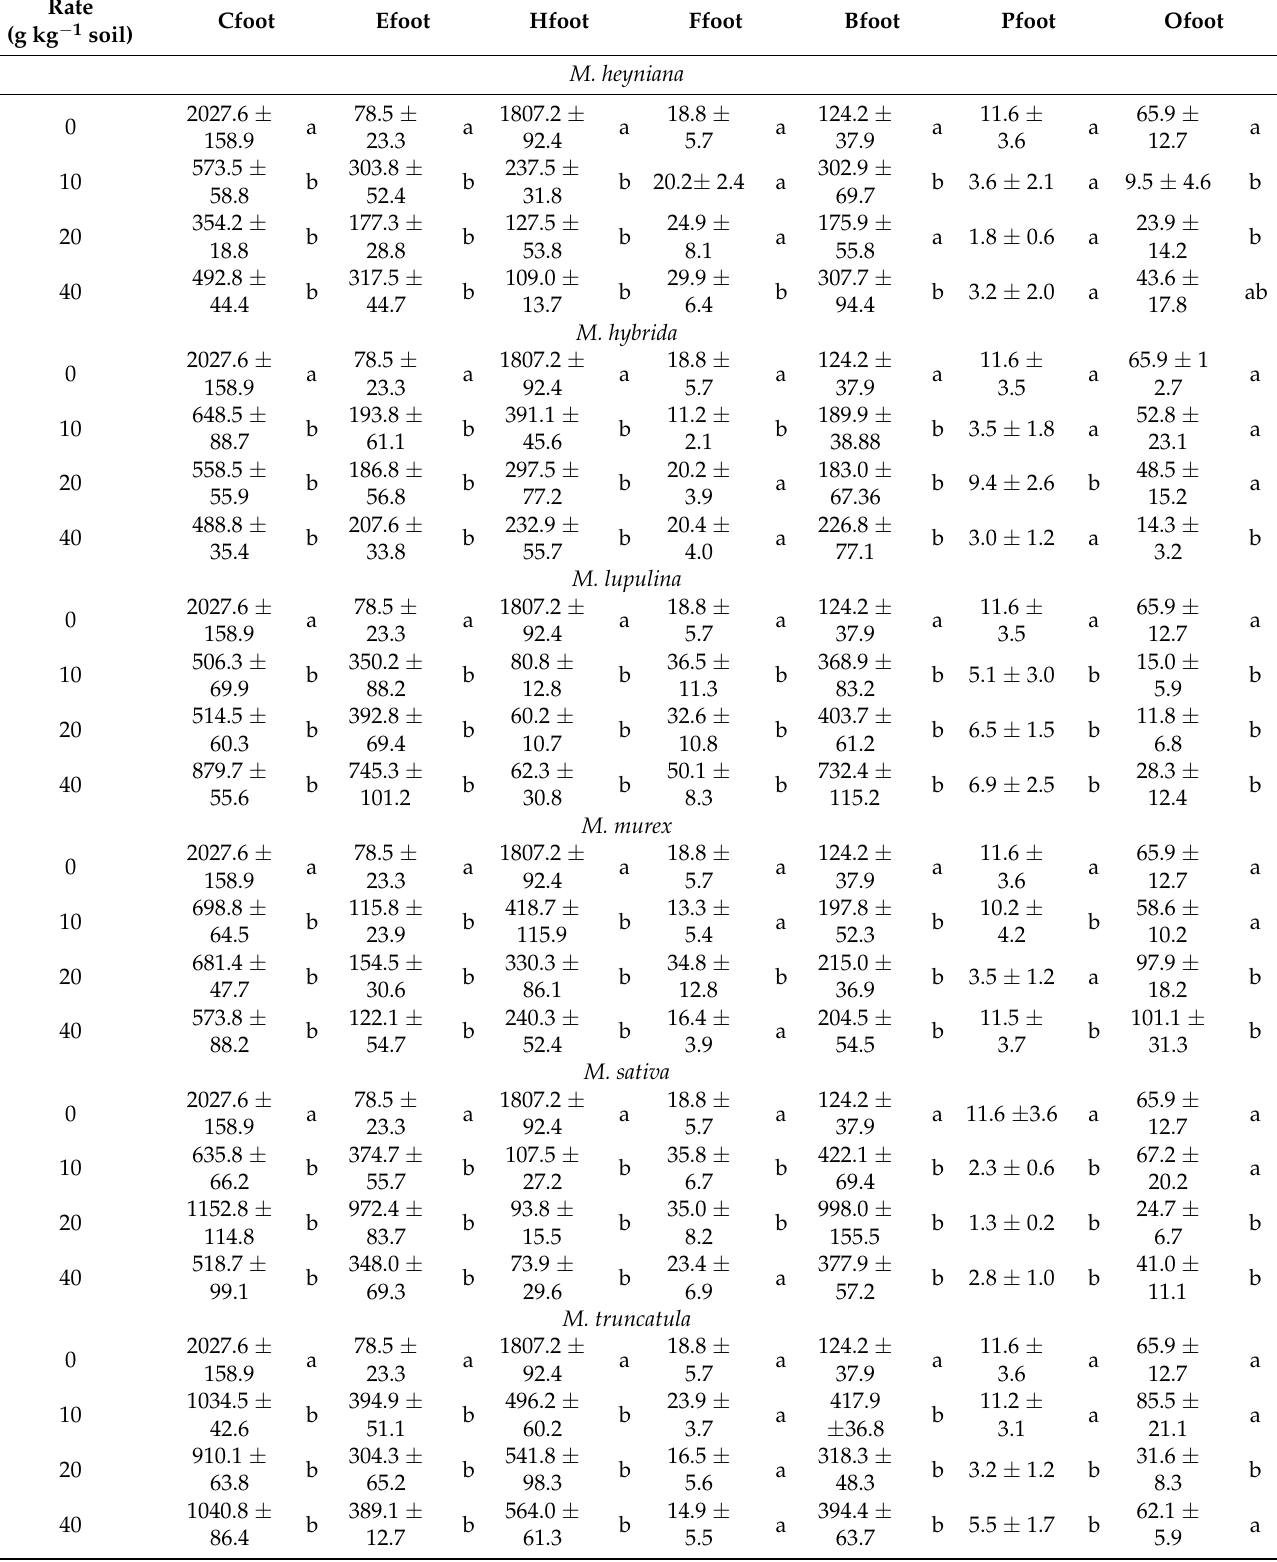
Table 2. Nematode metabolic footprints (means ± SE) after soil treatment with dry biomass from six Medicago species. Rate Cfoot Efoot Hfoot Ffoot (g kg − 1 soil)